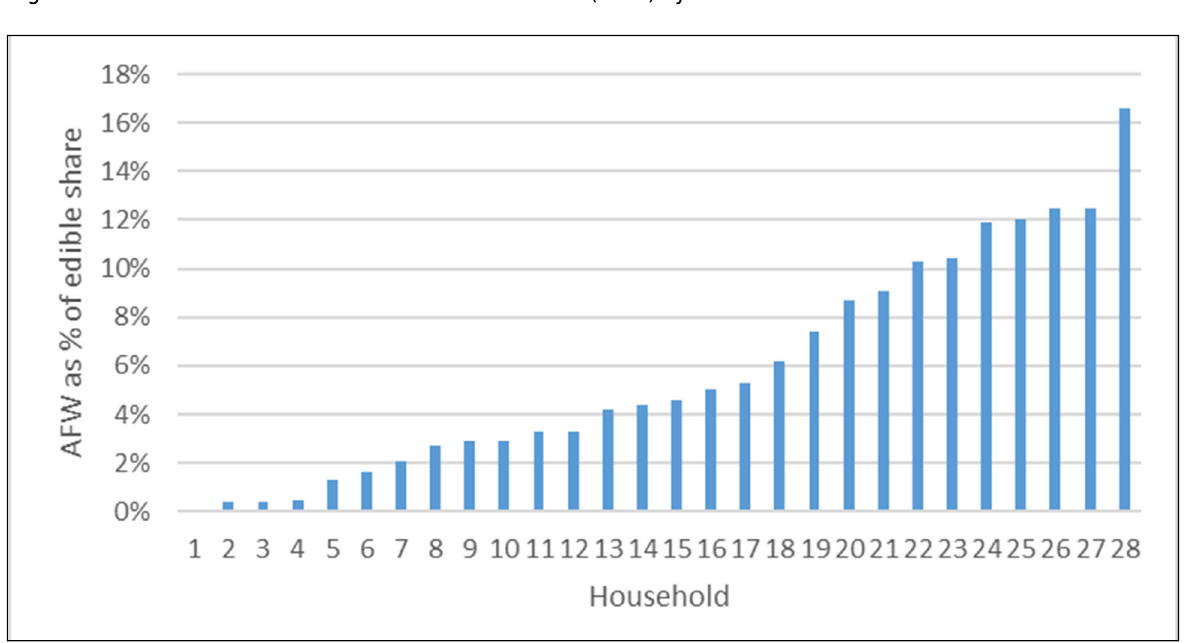
Figure 3. Canalside Members’ Avoidable Food Waste (AFW) by